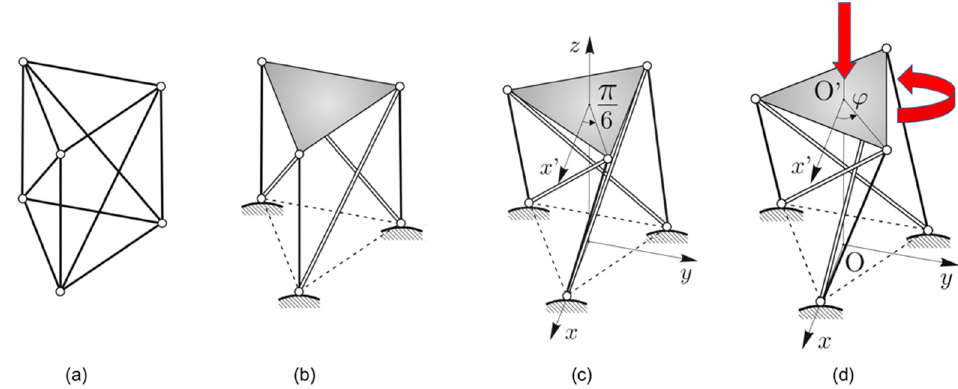
Figure 2. Design process of a tensegrity structure. ( a ) A bar framework in the shape of a regular right prism. ( b ) A corresponding right-handed tensegrity prism with cables (single line) and bars (double line). ( c ) Prestress-stable equilibrium configuration of the tensegrity prism. ( d ) When the internal mechanism is activated, the top triangle rotates about and translates along the vertical three-fold symmetry axis.